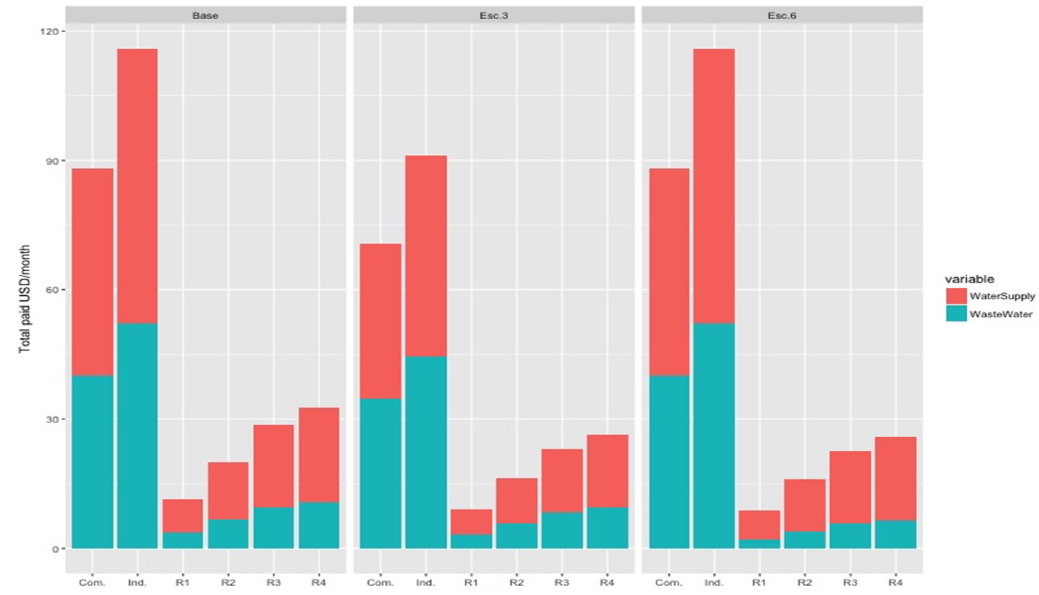
Figure 7. Comparison of the pay for services in baseline and the sceneries 3 and 6 for Figure 7 Comparison of the pay for services in baseline and the sceneries 3 and 6 for Tunjuelo Tunjuelo Catchment.